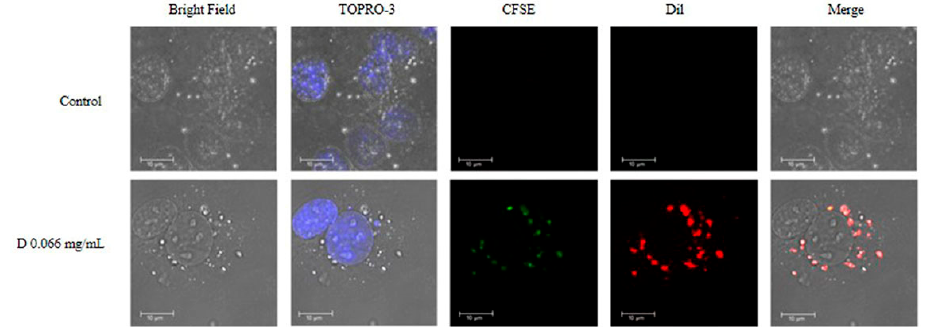
Figure 8. Intracellular localization of DNPs. HMEC-1 cells were seeded on round coverslips placed in 24-well plates at a concentration of 150,000 cells/well and incubated in a complete medium for 24 h. The media was replaced with a 2% FBS medium for 24 h. HMEC-1 cells were treated with 0.066 mg/mL of DNPs (CFSE; green stain, Dil; red stain) for 48 h at 37 °C and 5% CO 2 . The cells were fixed and stained with TO-PRO-3 iodide. The coverslips were then mounted onto slides using glycerol and visualized using confocal microscopy; magnification ×40, and zoom 6. Representative images are presented.